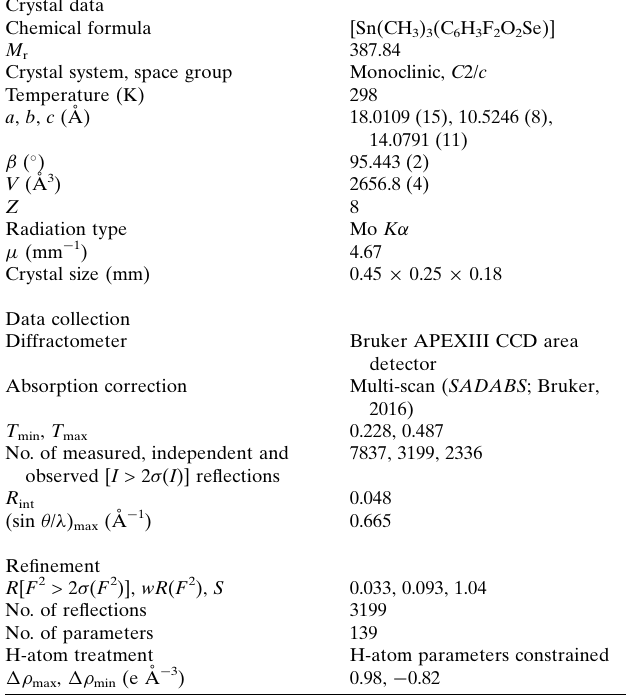
Table 2 Experimental details. Crystal data Chemical formula